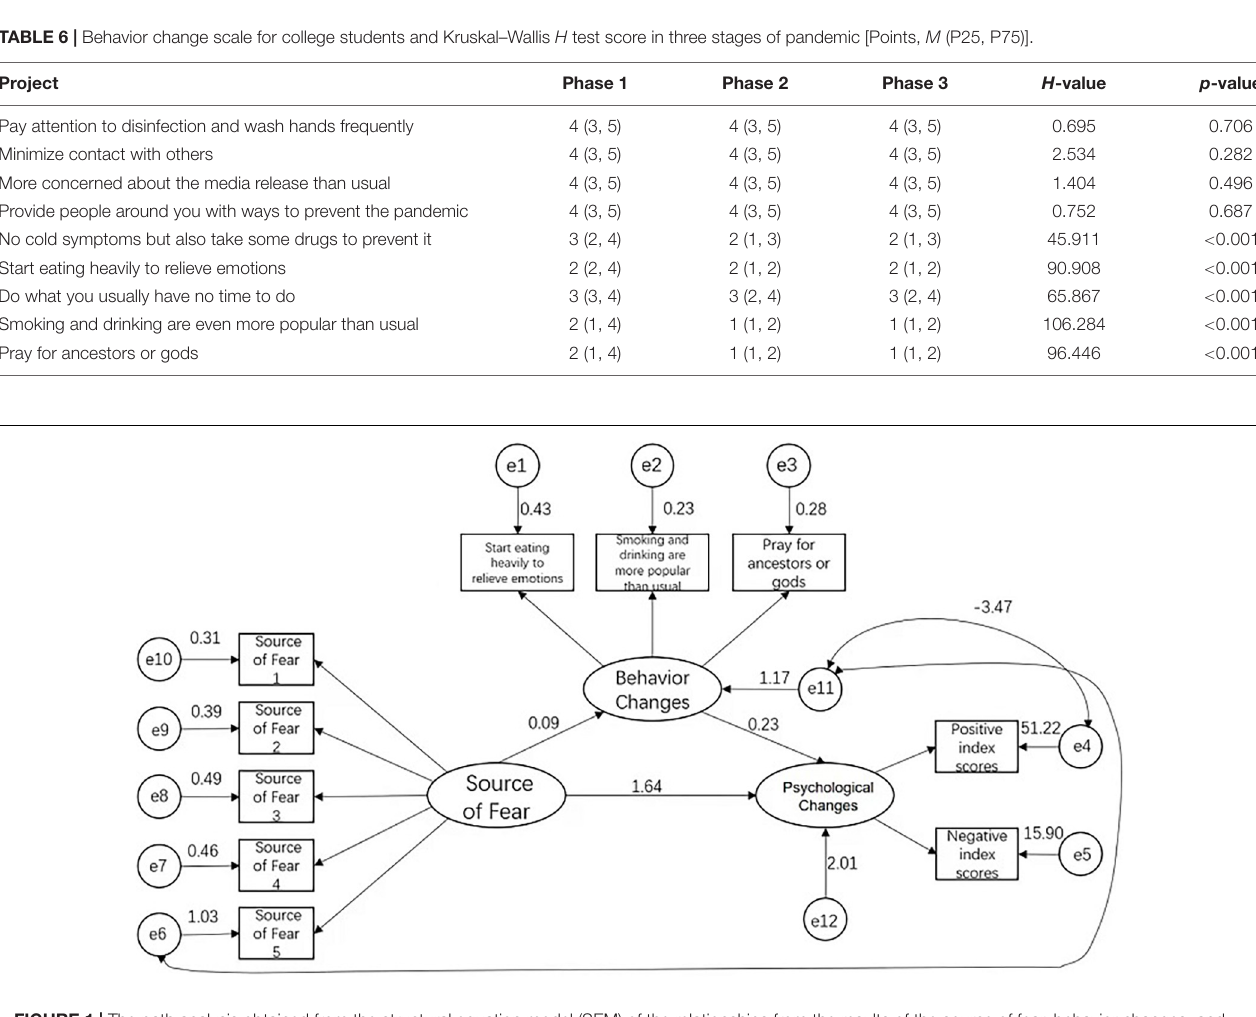
FIGURE 1 | The path analysis obtained from the structural equation model (SEM) of the relationships from the results of the source of fear, behavior changes, and psychological